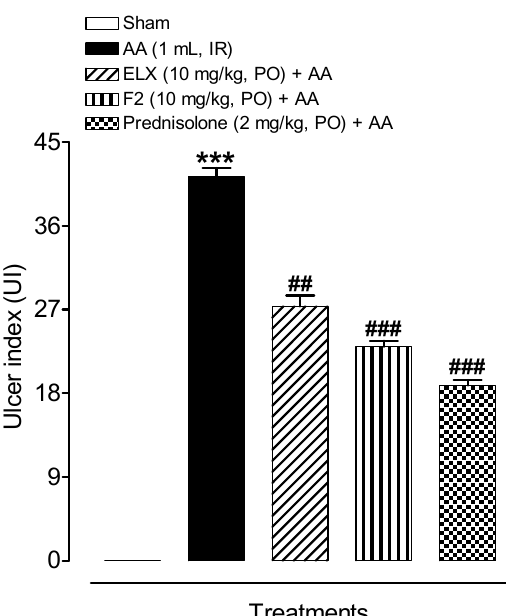
Figure 8. Pre-treatment with ELX and F2 decreased ulcer index in Wistar albino rats induced with AA colitis. Data are represented in means ± SEM ( n = 6). One-way ANOVA was used for statistical analysis followed by Tukey’s post-test. *** p < 0.001 compared with sham group; ## p < 0.01, ### p < 0.001 compared with AA alone. ELX = Eluxadoline, F2 = formulation, AA = acetic acid; PO = orally; IR = intrarectally.